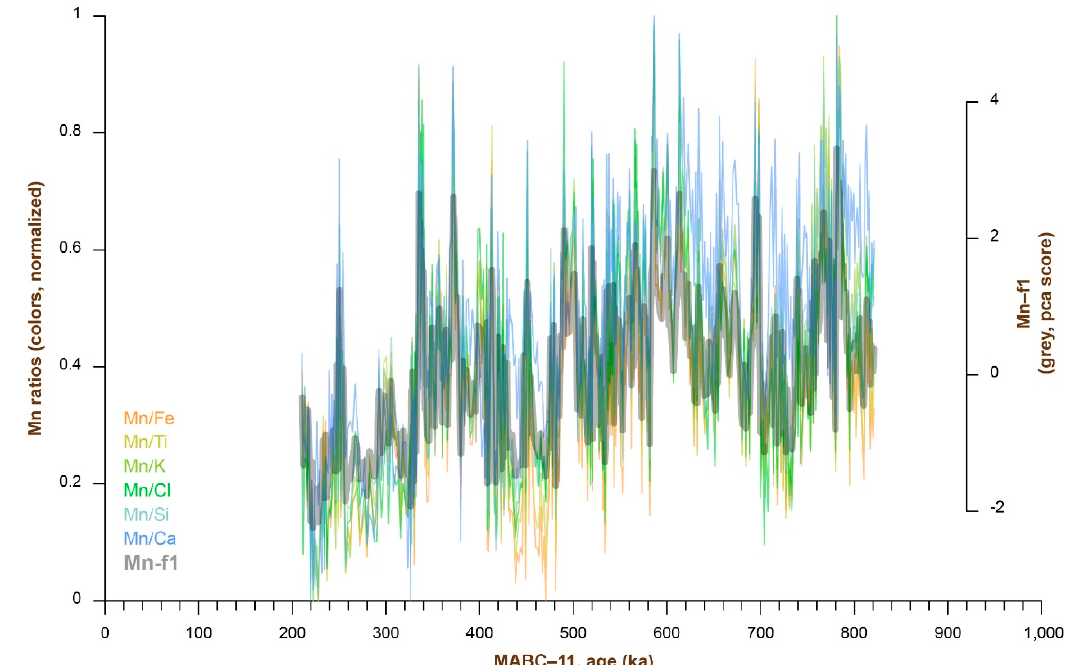
Figure 6. Element ratios and the first principal component (Mn–f1) of core MABC–11. All ratios were standardized into [0,1] to enable them to be plotted on the same scale (also see Table 2).